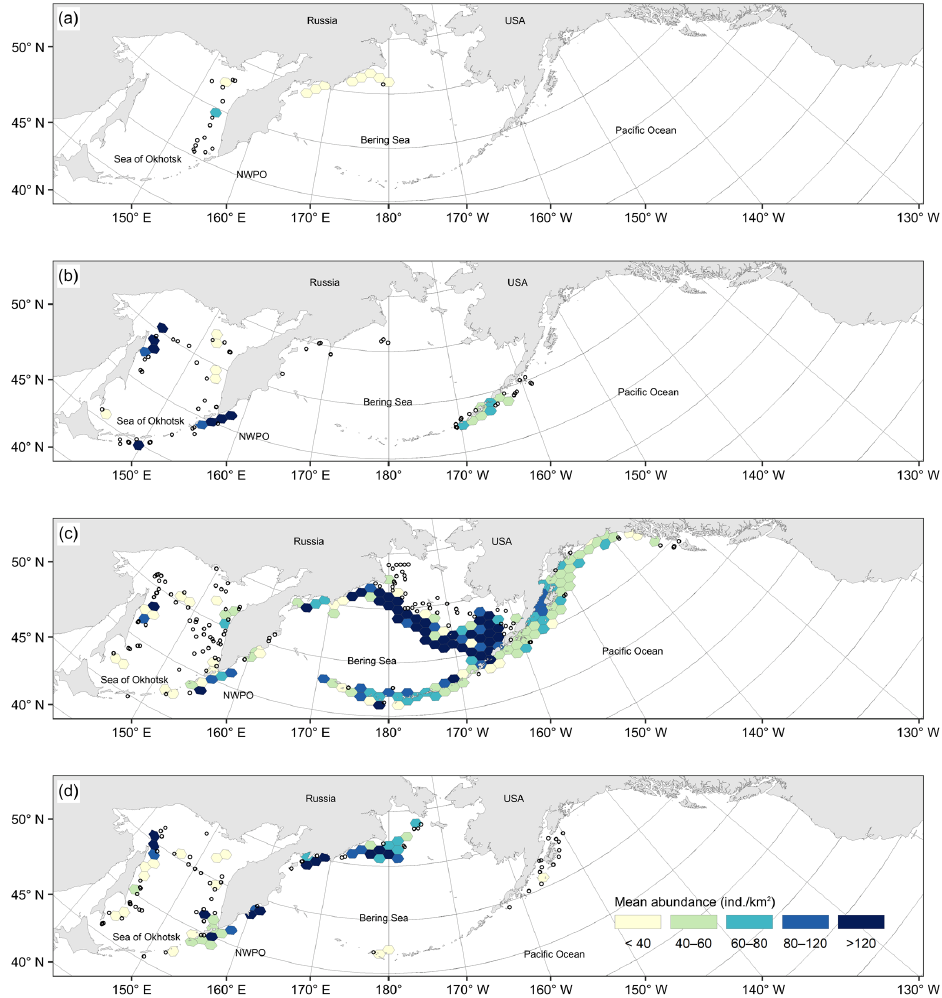
Figure 4. Mean abundance (ind./km 2 ) of the Aleutian skate Bathyraja aleutica in the North Pacific Ocean in ( a ) December–February, ( b ) March–May, ( c ) June–August, and ( d ) September–November. Small circles mark station locations outside of the hexagonal grid cells with at least three stations (see Methods).